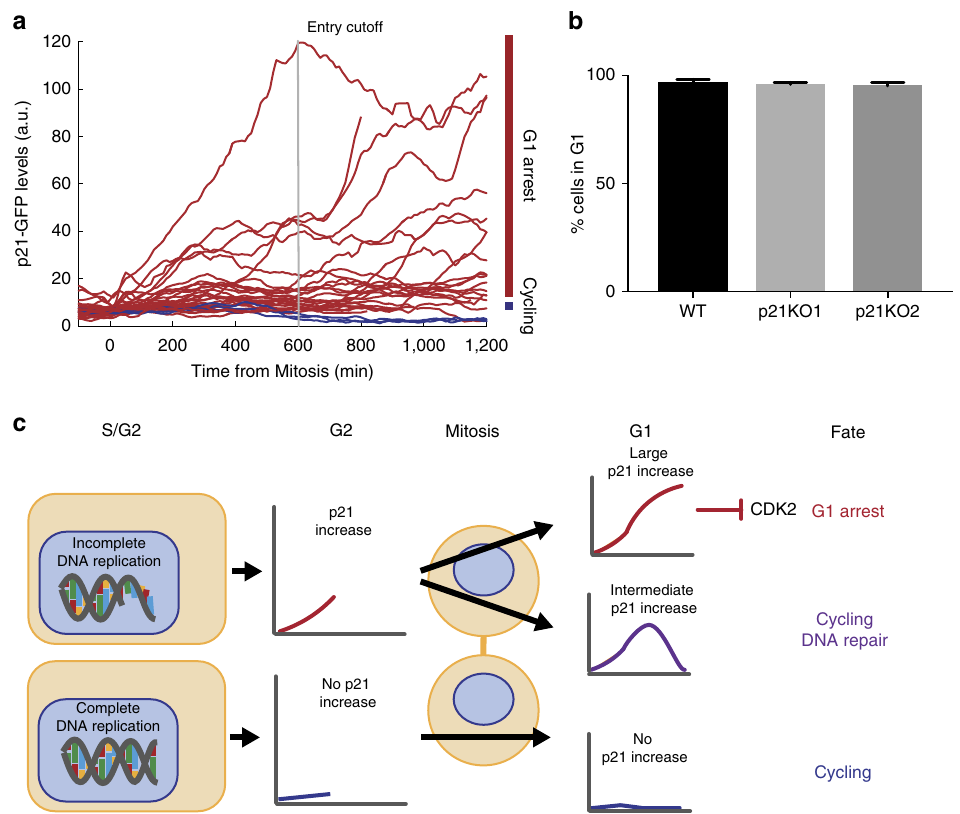
Figure 7 | Arrest in response to serum starvation is not p21-dependent. ( a ) Single-cell traces of p21-GFP levels aligned to mitotic exit (serum was withdrawn in the previous cycle); n ¼ 29 cells. Grey line marks 600min time point used to define G1pm arrest. Red curves represent cells entering G1pm arrest, blue curves represent cells that enter S-phase. ( b ) Graph showing the percentage of cells arresting in G1 in three different mRuby-PCNA hTert-RPE1 cell lines (WTand two p21KO clones) after serum withdrawal for 24h. Mean and s.d. of two independent FACS experiments are shown. ( c ) Model for how p21 propagates information on DNA damage in the mother cell to influence the proliferation-quiescence decision in daughter cells. At intermediate levels of p21 (purple curve) cells still cycle, albeit with a G1 delay that is p53-dependent but